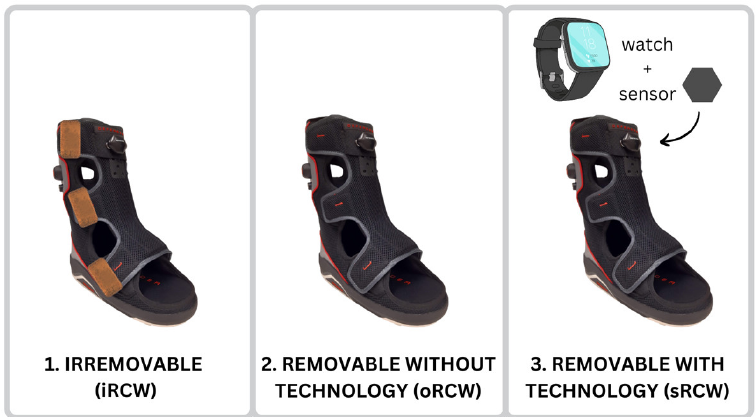
Figure 2. Participants were randomized to wear (1) an irremovable cast walker (iRCW), (2) an original removable cast walker that is standard of care (oRCW; OG indicates original gadget), or (3) a smart removable cast walker designed to provide feedback on adherence via a sensor and smartwatch (sRCW).